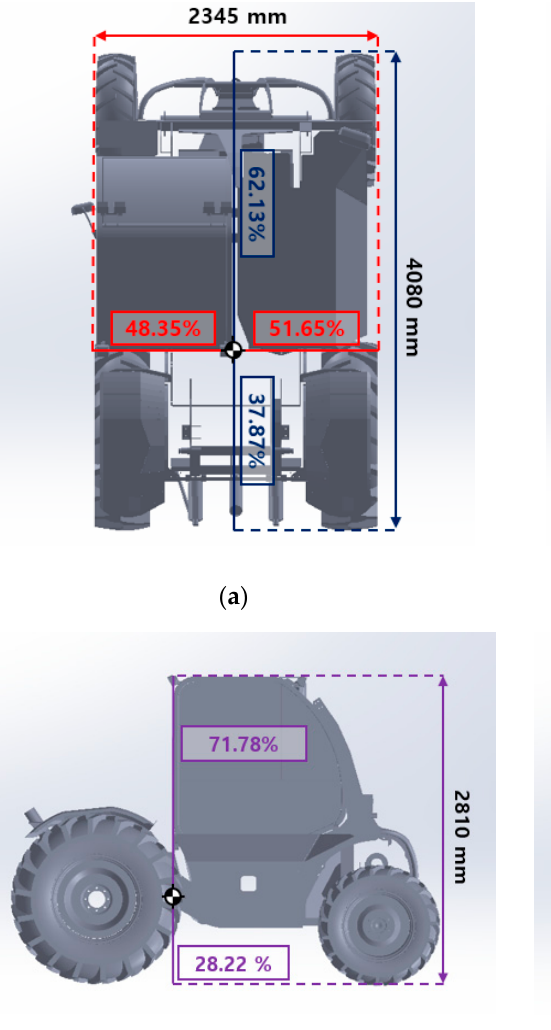
Figure 4. 3D model of the tractor used: ( a ) Front view; ( b ) Isometric view; ( c ) Bottom view; ( d ) Side view.